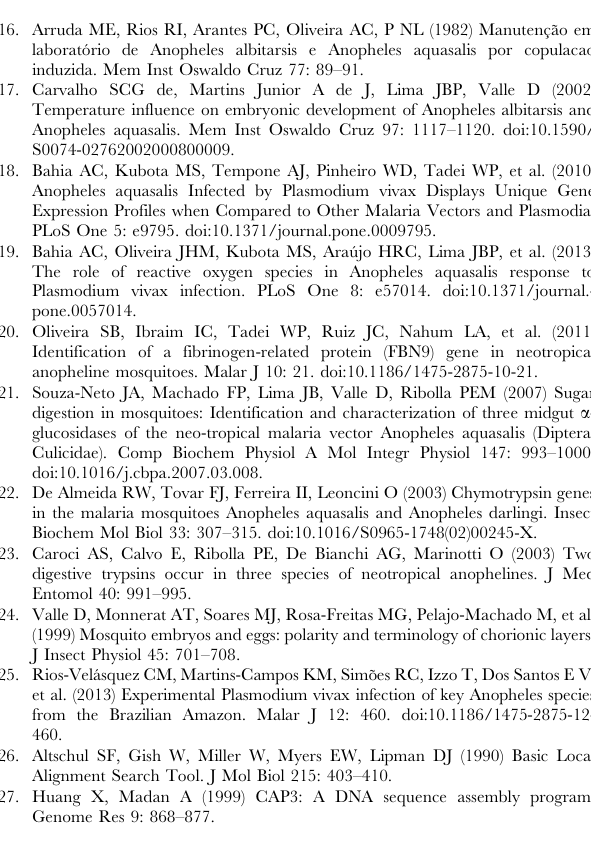
Figure S3 Validation of larva enhanced and specific transcripts by qRT-PCR. Expression levels of 5 genes (Anoaqua-397, Anoaqua-4095, Anoaqua-1222, Anoaqua-1598 and Anoaqua- 17360) were determined in samples from An. aquasalis L3/L4 larvae pools (Larvae), adult females fed on sucrose (Sucrose-fed) and adult females 24 hs post blood meal (Blood-fed). Relative mRNA levels are displayed as the mean of fold differences in relation to calibrator sample (Sucrose-fed for Anoaqua-397 and Anoaqua-4095; Blood-fed for Anoaqua-1222, Anoaqua-1598 and Anoaqua-17360) and error bars represent the standard error of the mean ( 6 S.E.M.). Expression levels of Anoaqua-397, Anoaqua- 4095, Anoaqua-1222 and Anoaqua-1598 in Larvae samples are significant different in relation to other measured samples (One way ANOVA test. *, p , 0.0001). Expression levels of Anoaqua- 17360 in Larvae samples are significant different in relation to other samples (Kruskal-Wallis test. *, p , 0.0001). Figure S4 Validation of adult enhanced and specific transcripts by qRT-PCR. Expression levels of 2 genes (Anoaqua-436 and Anoaqua-457) were determined in samples from An. aquasalis L3/ L4 larvae pools (Larvae), adult females fed on sucrose (Sucrose-fed) and adult females 24 hs post blood meal (Blood-fed). Relative mRNA levels are displayed as the mean of fold differences in relation to calibrator sample (Larvae) and error bars represent the standard error of the mean ( 6 S.E.M.). Expression levels of Anoaqua-436 and Anoaqua-457 in Larvae samples are significant